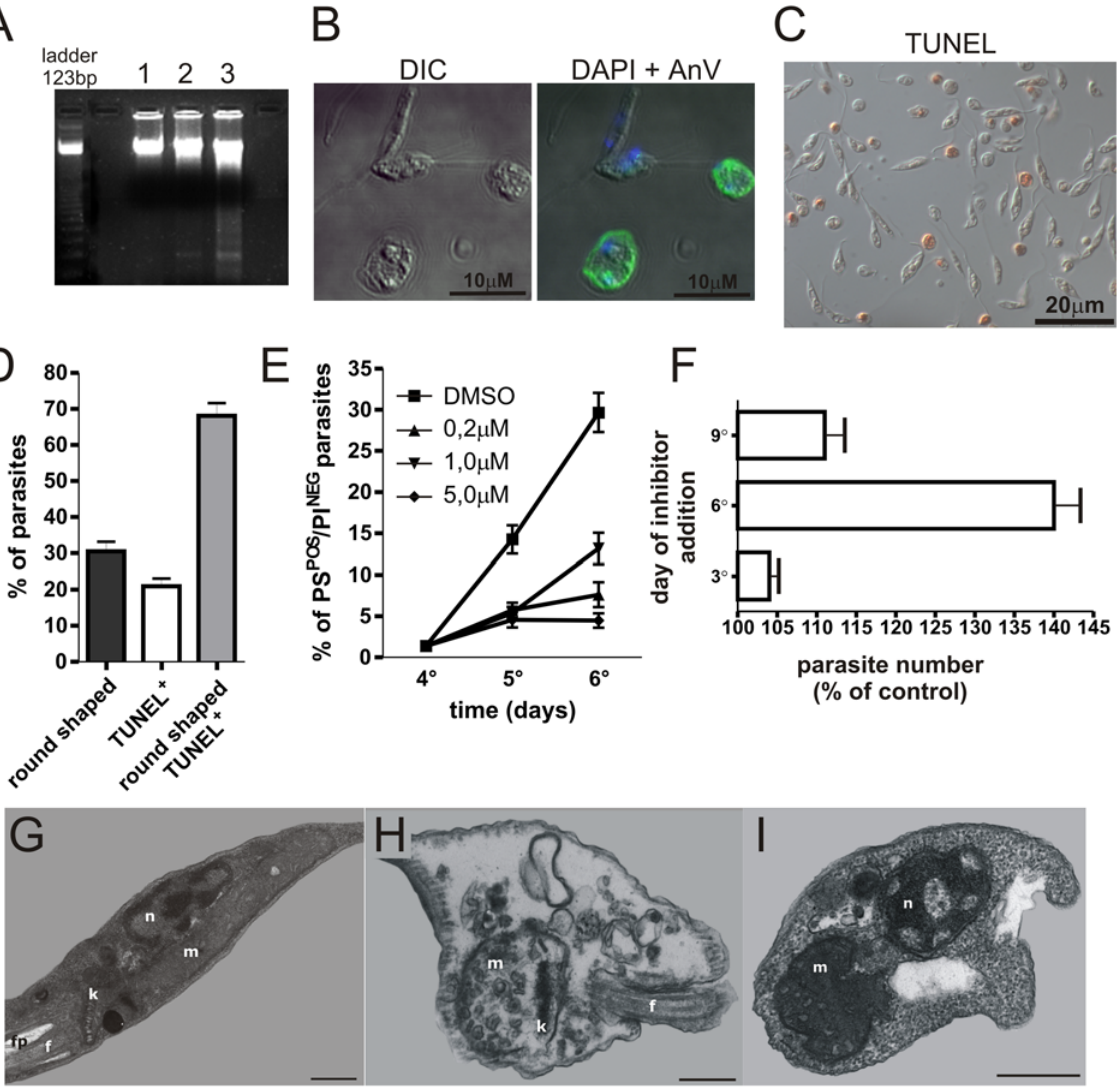
Figure 5. PS POS parasites are apoptotic cells. ( A ) Oligonucleosomal DNA cleavage in logarithmic phase (lane 1), stationary phase (lane 2) and purified metacyclic (lane 3) promastigote populations. ( B ) Differential interference contrast (left panels) and confocal microscopy (right panels) Confocal image of purified metacyclics stained with AnV-Alexa 488 and DAPI. ( C ) TUNEL staining of stationary-phase promastigotes. ( D ) Quantification of TUNEL POS and round shaped parasites by counting at least 200 parasites per slide under the microscope. ( E ) PS exposure by PI NEG parasites treated with a pan-caspase inhibitor Z-VAD-FMK. ( F ) Proliferation of parasites treated with 10 m M of Z-VAD-FMK at day 3, 6 and 9 of culture. Ultrastructural analysis of ( G ) metacyclic promastigote and ( H and I ) PS POS metacyclics showing morphology of nucleus (n), mitochondrion (m), kinetoplast (k), flagellar pocket (fp) and flagellum (f). Bars represent 1 m m.